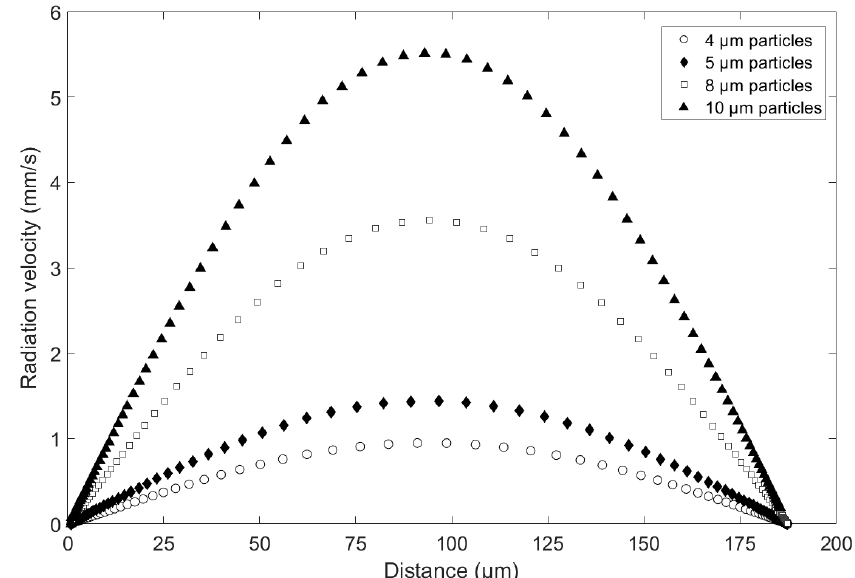
Figure 4. Radiation velocity of polystyrene particles along the width of the channel for different particle diameter (see legend). Data were obtained by COMSOL simulations.